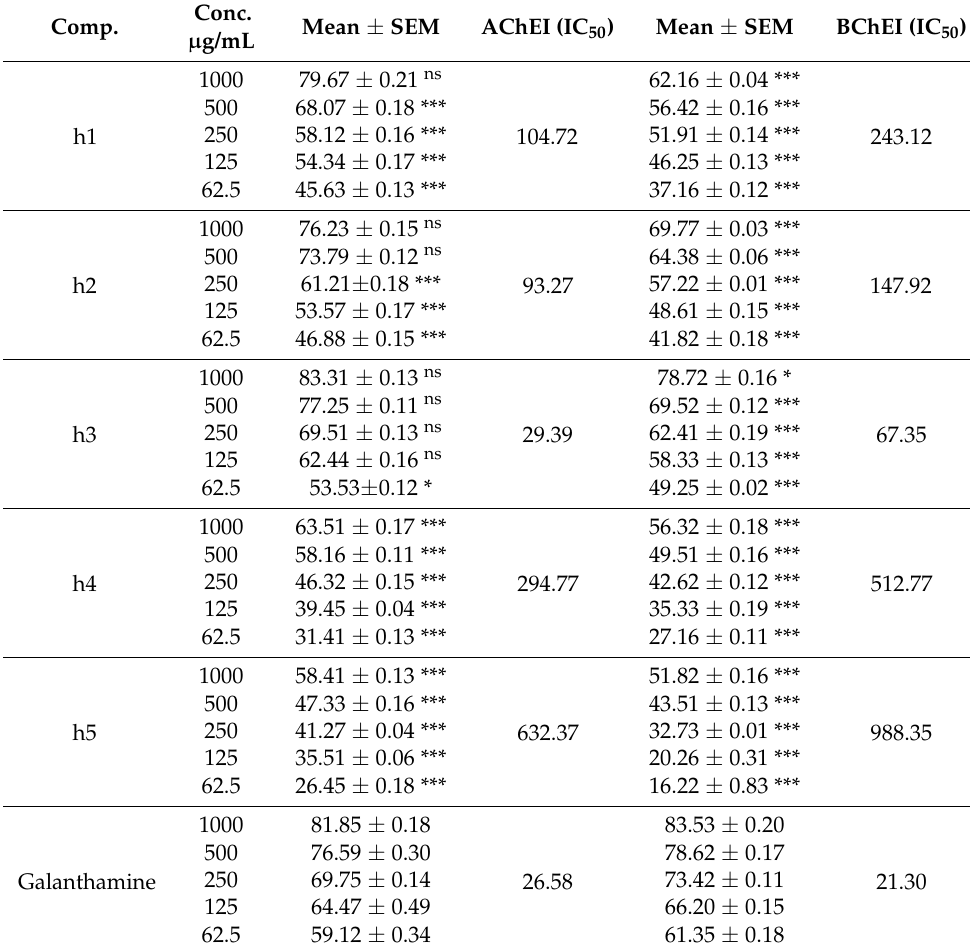
Table 2. In vitro cholinesterase inhibition potential of curcumin analogs. Comp.